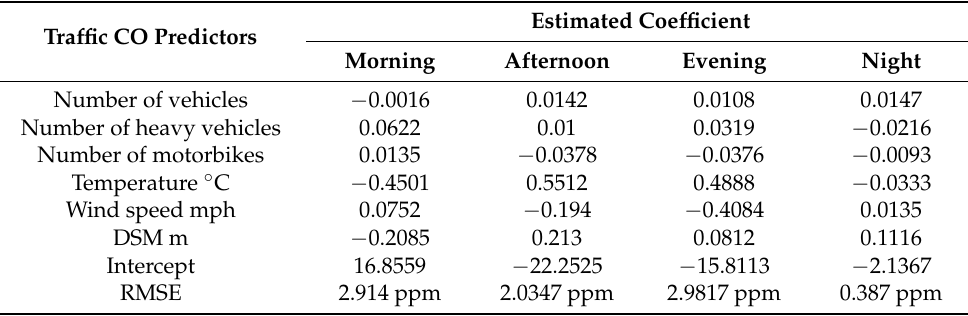
Table 6. Regression models for traffic CO prediction based on the CFS-MLP model. Estimated Coefficient Traffic CO Predictors Morning